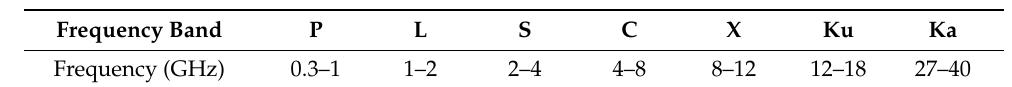
Table 1. Frequency bands used in SAR